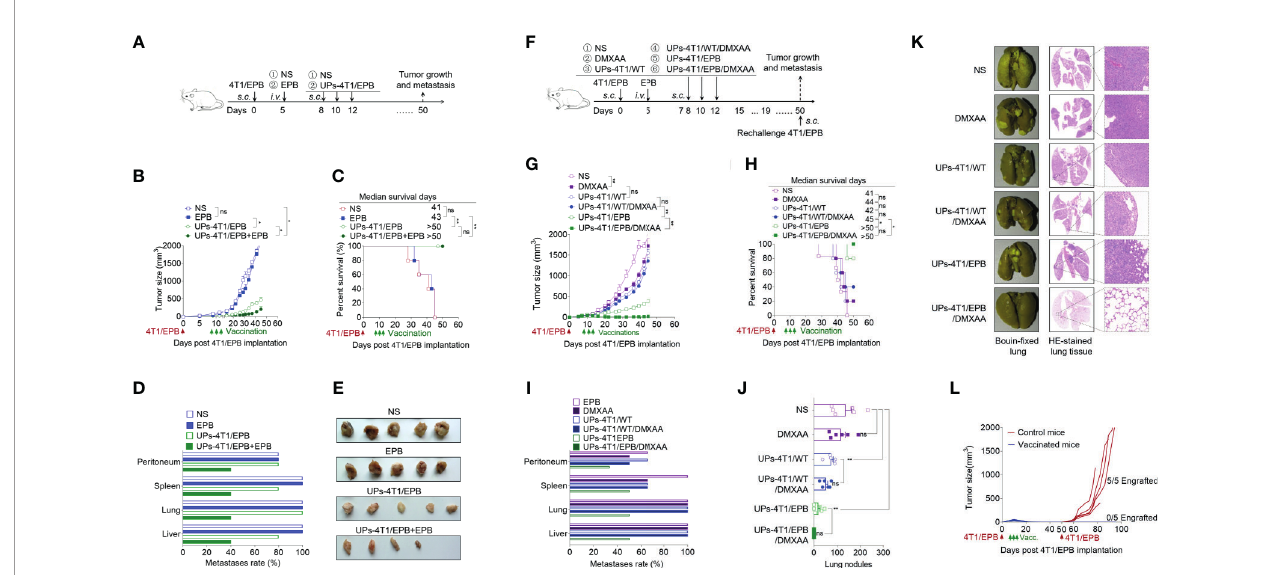
FIGURE 4 | Combination of ubiquitinated proteins (UPs)-4T1/epirubicin (EPB) nanovaccine with chemotherapy and stimulator of interferon genes (STING) agonists led to primary tumor regression and pulmonary metastasis eradication. (A) Immunization protocol of UP vaccination combined with chemotherapy. (B – E) The tumor growth (B) and survival (C) of mice ( n = 5 to 6 per group) were monitored. Metastasis rate (D) and tumor photos (E) of tumor-bearing mice. (F) Immunization protocol of UP vaccination combined with chemotherapy and STING agonists. (G – L) The tumor growth (G) , survival (H) , and metastasis rate (I) of tumor-bearing mice ( n = 6 per group) were monitored. Representative Bouin ’ s- fi xed lungs and microscopic sections of lung tissues with HE stain (J) . The pulmonary metastatic nodules of the lung tissue were counted (K) . (L) The vaccinated mice that rejected the tumor following the combination therapy of UPs-4T1/EPB nanovaccine and 5,6-dimethylxanthenone-4-acetic acid treatment ( fi ve of the six treated mice) in (G) were rechallenged with 5 × 10 5 4T1/EPB tumor cells, and the tumor growth was monitored. P -values were determined by Mann – Whitney U -test. Kaplan – Meier survival curves were assessed by the log-rank Mantel – Cox test (C, H) . The results are representative of three independent experiments, and data were expressed as means ± SEM (* p < 0.05; ** p < 0.01; ns, not signi fi